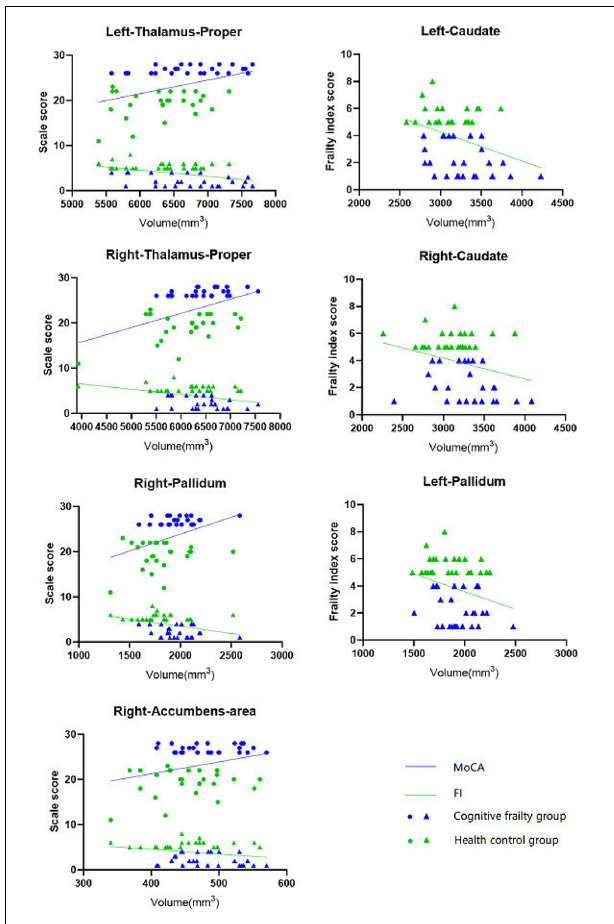
FIGURE 4 | Correlation between subcortical nucleus volume and MoCA, FI values after adjusted for age, sex and education. The nucleus volume in left and right thalamus-proper, right pallidum and right accumbens-area was positively correlated with the MoCA scores ( P < 0.05); the nucleus volume in left and right thalamus-proper, left and right caudate, left and right pallidum, and right accumbens-area was negatively correlated with the frailty index scores ( P < 0.05). MoCA, Montreal Cognitive Assessment; FI, Frailty index.